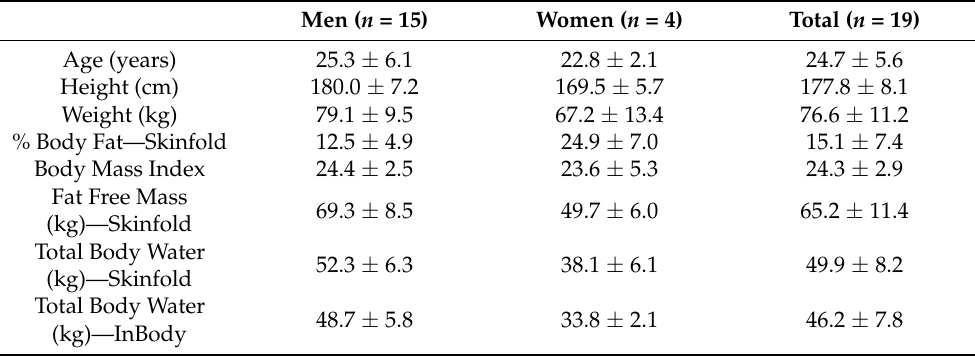
Table 1. Mean ( ± SD) Subject Physical